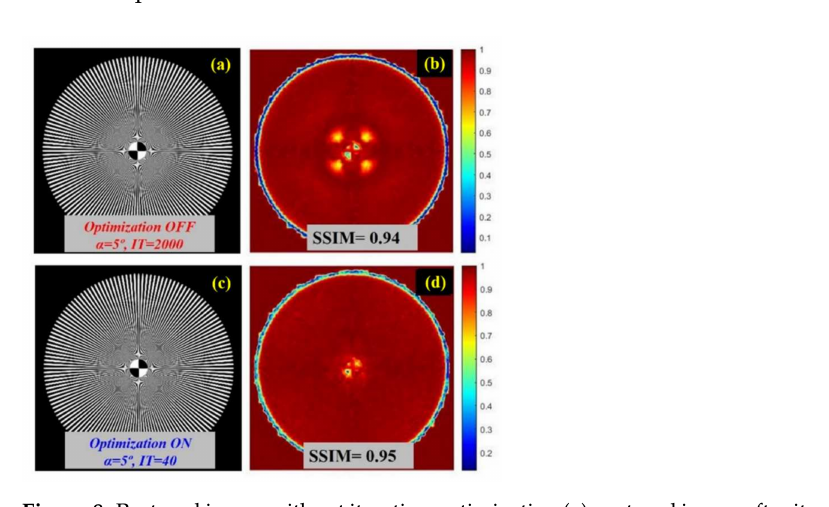
Figure 8. Restored image without iteration optimization ( a ), restored image after iteration optimization ( c ), and SSIM maps ( b ) computed from Figures 7a and 8a and ( d ) from Figures 7a and 8c.